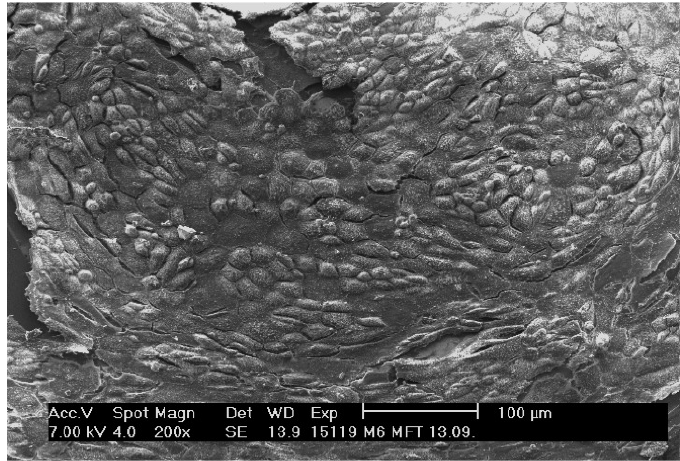
Figure 2. Scanning electron microscopy of CPCs growing on the sensor chip. The cells